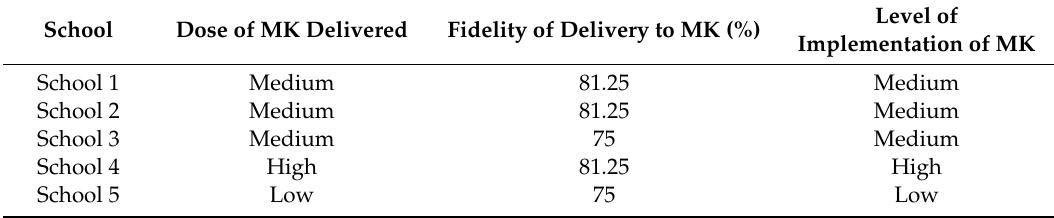
Table 7. Summary of the level of implementation of Marathon Kids